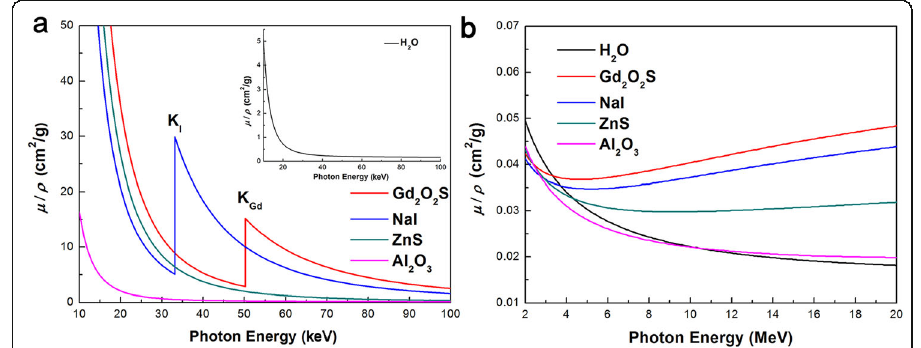
Fig. 2 The photon mass attenuation coefficients μ / ρ ( g ∙ cm − 3 ) of IOSs Gd 2 O 2 S, NaI, ZnS, and Al 2 O 3 for photons in the energy ranges 10 – 100keV ( a ), and 2 — 22MeV respectively. The insert in ( a ) is the mass attenuation coefficient of H 2